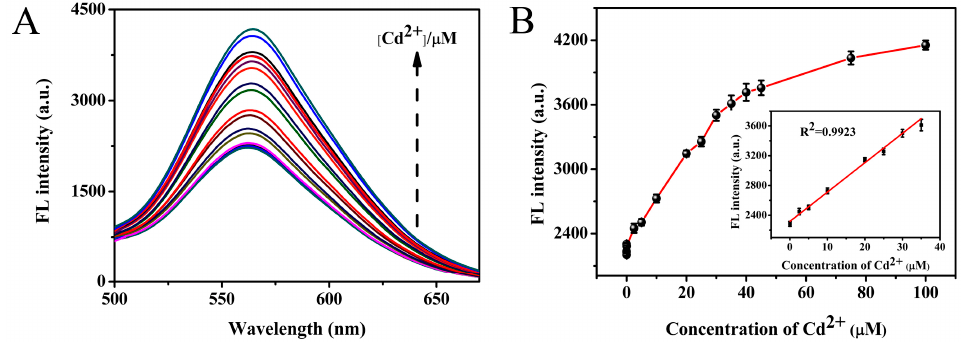
Figure 6. ( A ) The fluorescence response of the Au NCs in the presence of various concentrations of Cd 2+ (0.0025, 0.005, 0.025, 0.05, 2.5, 5, 10, 15, 20, 25, 30, 35, 40, 45, 50, 75, 100 μ M); ( B ) Relationship between fluorescence intensity and Cd 2+ concentration. The inset picture shows the linear detection range for 0.05–35 µ M of Cd 2+ .